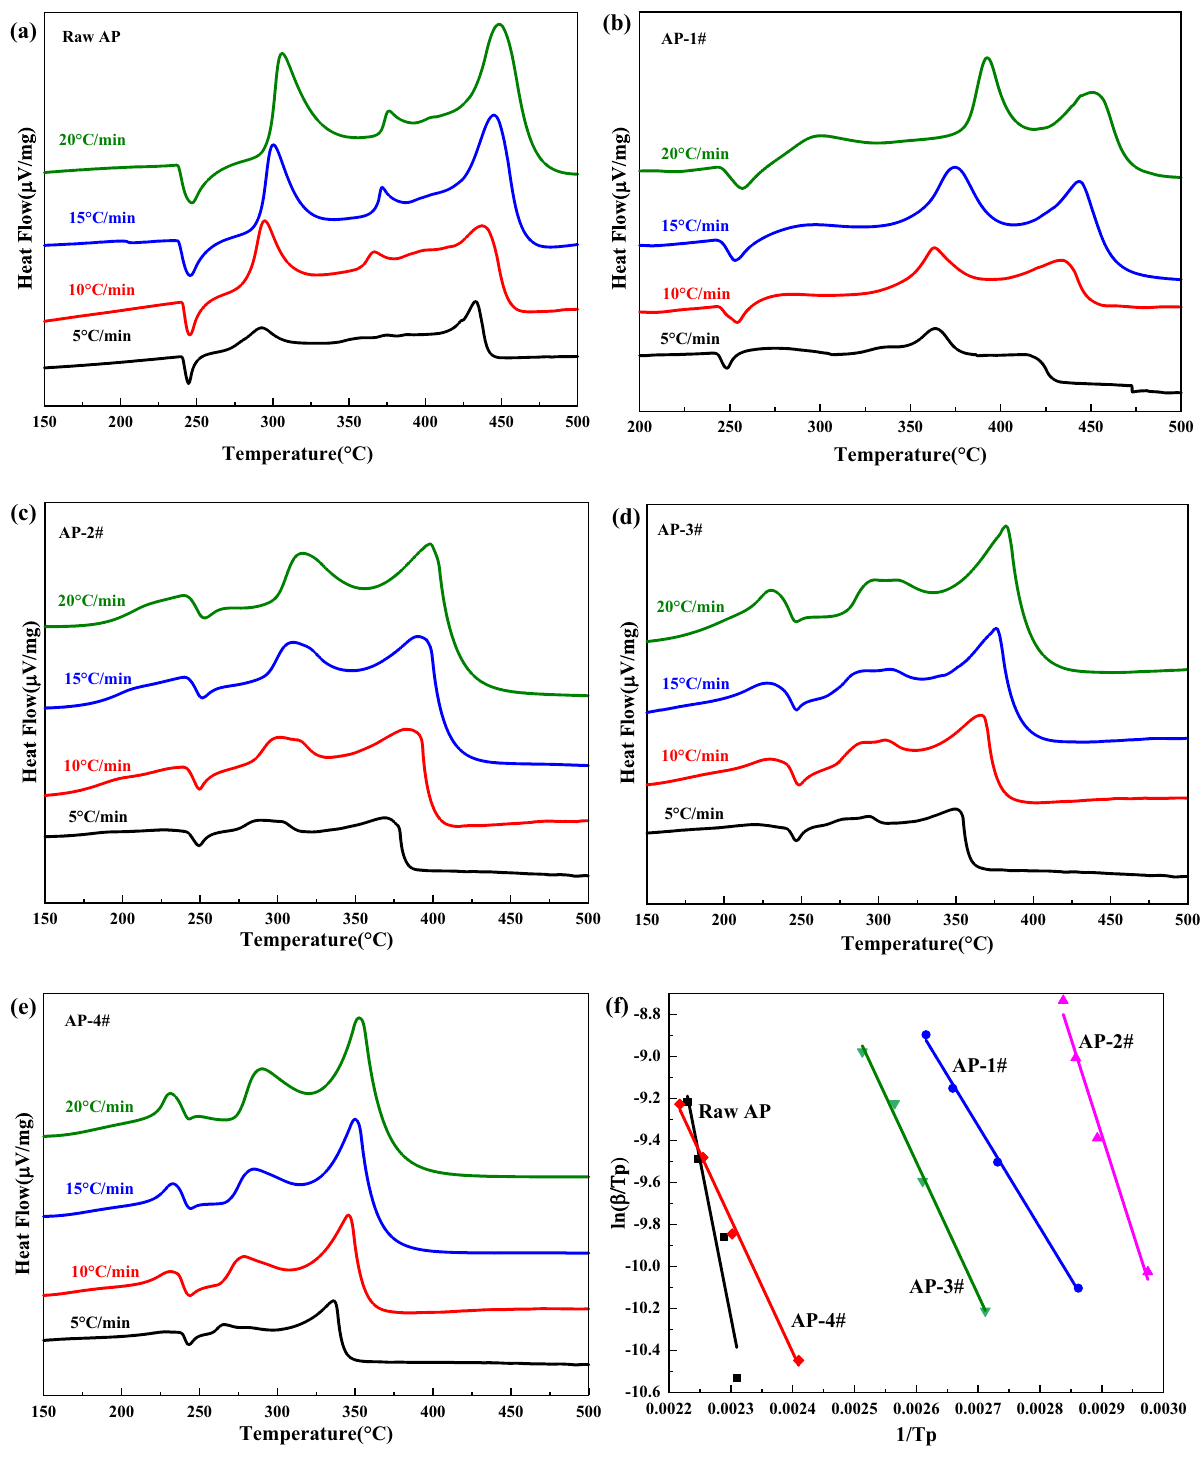
Figure 9. DSC curves of raw AP and laminated AP composite at different heating rates, and the dependence of ln (β/T p2 ) on 1/T p for above